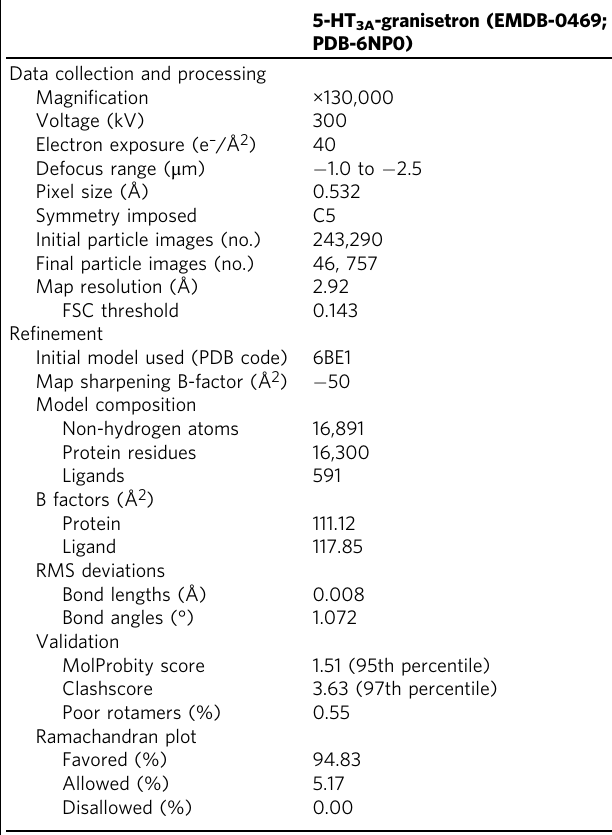
Fig. 1 Cryogenic electron microscopy (cryo-EM) structure of granisetron-bound full-length serotonin 3A receptor (5-HT 3A R). a A schematic showing three fundamental conformations that constitute the gating cycle in pentameric ligand-gated ion channel (pLGIC) function: a resting state, a transient open state, and a desensitized state. Agonist-binding shifts the equilibrium towards the open state and then to the high-agonist af fi nity, desensitized state. Orthosteric (competitive) antagonists exert their effect by shifting the equilibrium towards the resting (or inhibited) state. b Trace showing a continuous recording of 5-HT 3A R currents ( − 60 mV) in oocytes measured by two-electrode voltage clamp (TEVC) in the presence of serotonin (marked by red line) and pre- applied granisetron (marked by orange line). The effect of granisetron inhibition was fully reversible as seen in the third pulse. c Map of full-length 5-HT 3A R-granisetron reconstructed from 46,757 particles at 2.92 Å resolution. Side-view parallel to the membrane and extracellular view are shown in left and right panels, respectively. Each monomer is shown in a different color for clarity. Density corresponding to granisetron (left panel, circle) and glycans (right panel, arrow) are indicated. d Three-dimensional cartoon model of 5-HT 3A R-granisetron structure generated from EM reconstruction (side view). For each subunit, three sets of glycans are shown as stick representation. e Top-view of 5-HT 3A R-granisetron map sliced at the binding site to show all fi ve granisetron molecules, each bound at the interface of two subunits (indicated by arrows)